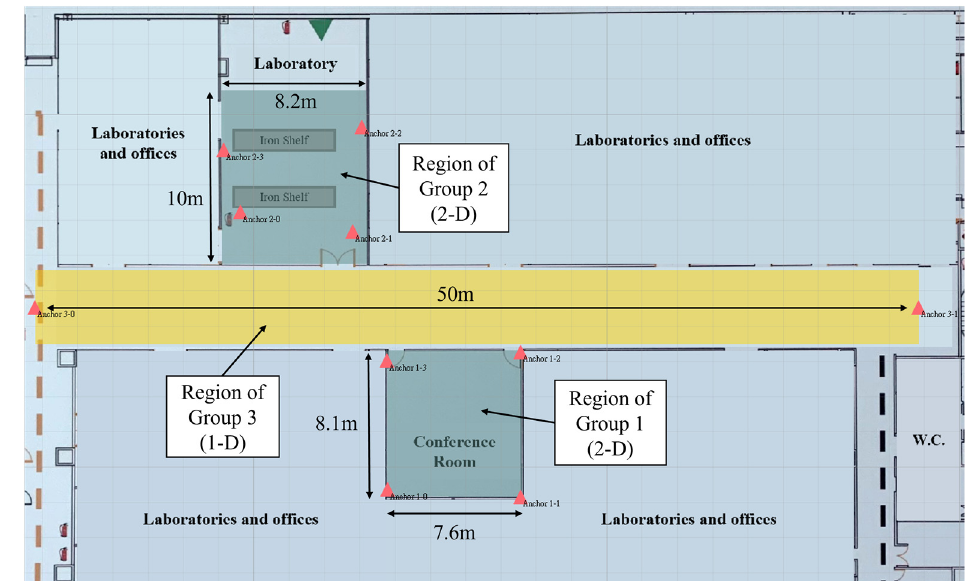
Figure 21. Deployment of groups.